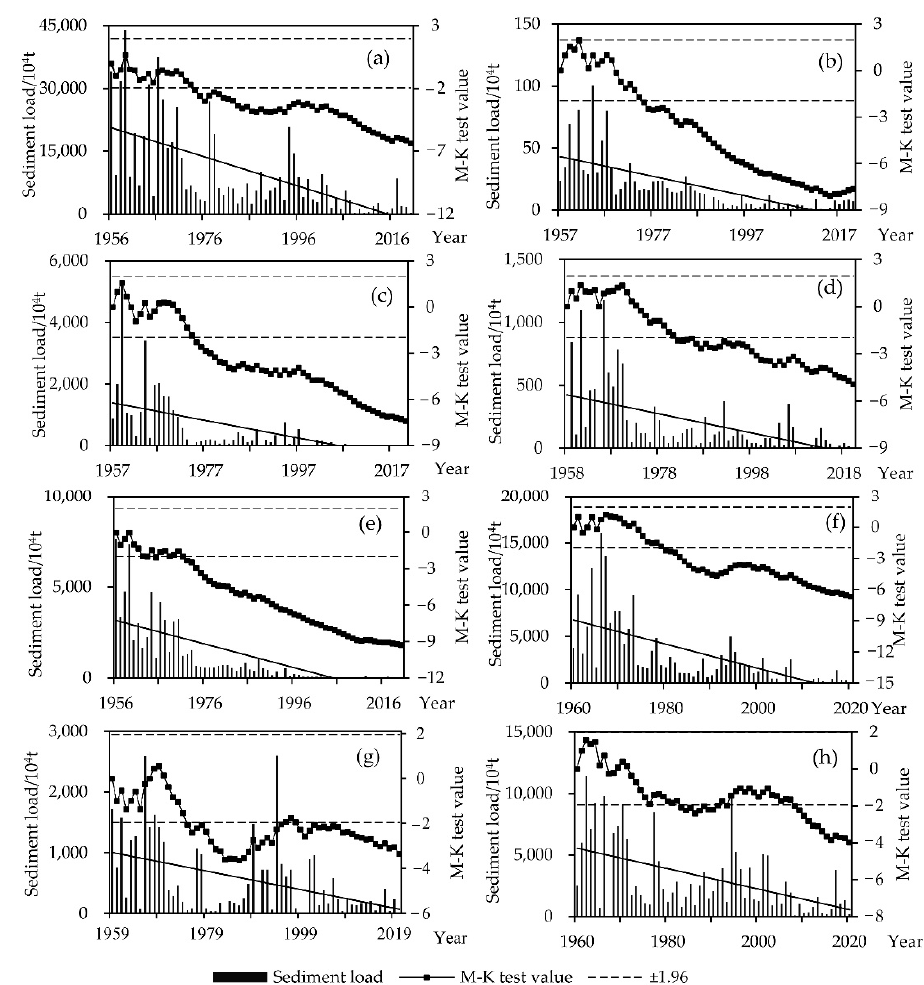
Figure 3. Variations in the sediment load and M–K test values in the Wuding River basin. ( a ) Baijianchuan gauging station; ( b ) Hanjiamao gauging station; ( c ) Hengshan gauging station; ( d ) Dianshi gauging station; ( e ) Zhaoshiyao gauging station; ( f ) Dingjiagou gauging station; ( g ) Lijiahe gauging station; ( h ) Suide gauging station.